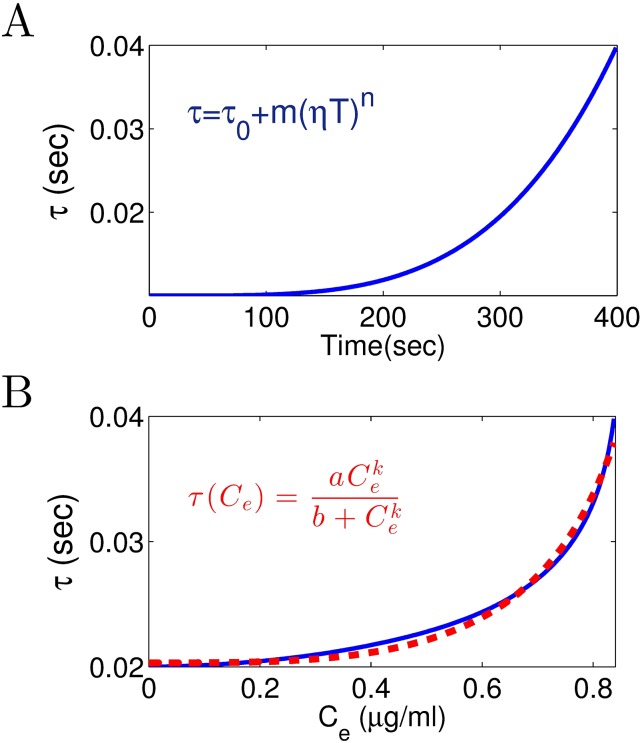
(A) According to Eq (18), the time delay τ is plotted with the respect to administration time (T). Note that inserting p(T) = ηT + 1 into Eq (17) gives the relation Eq (18). (B) From panels A and Fig 9A, time delay τ is plotted with the respect to propofol concentration Ce (blue line). The function Eq (19) is fitted to the extracted curve (dashed red line).